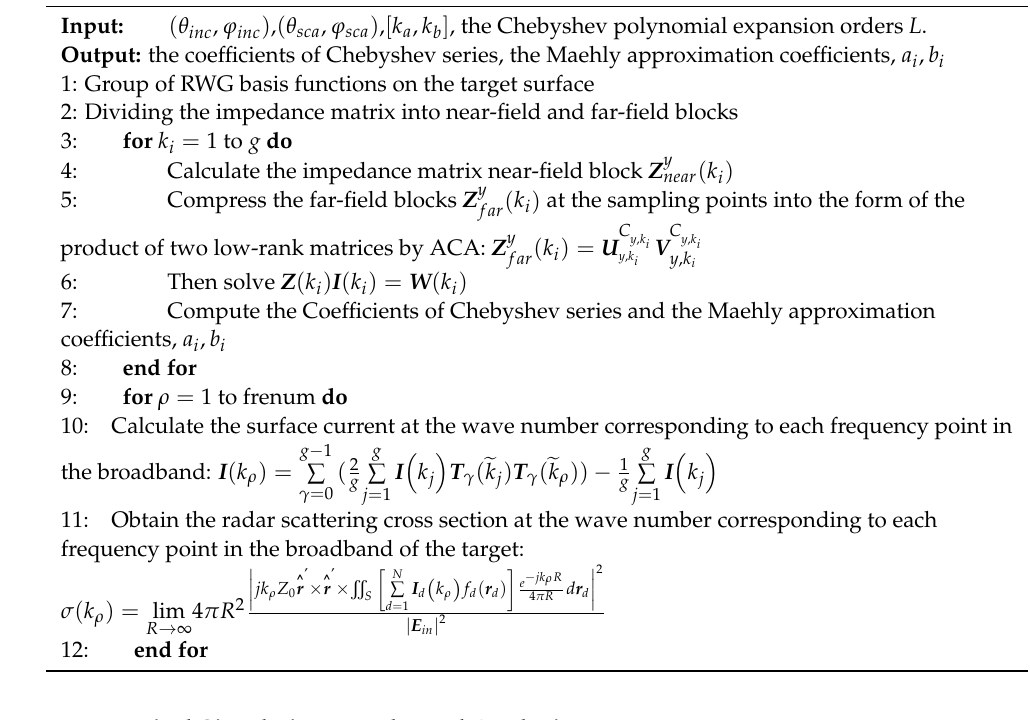
Algorithm 1 the hybrid ACA-CAT